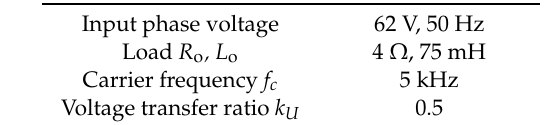
Figure 10. Laboratory model of MC: ( a ) Diagram system; ( b ) power and control system. Table 5. The parameters used in laboratory measurements.